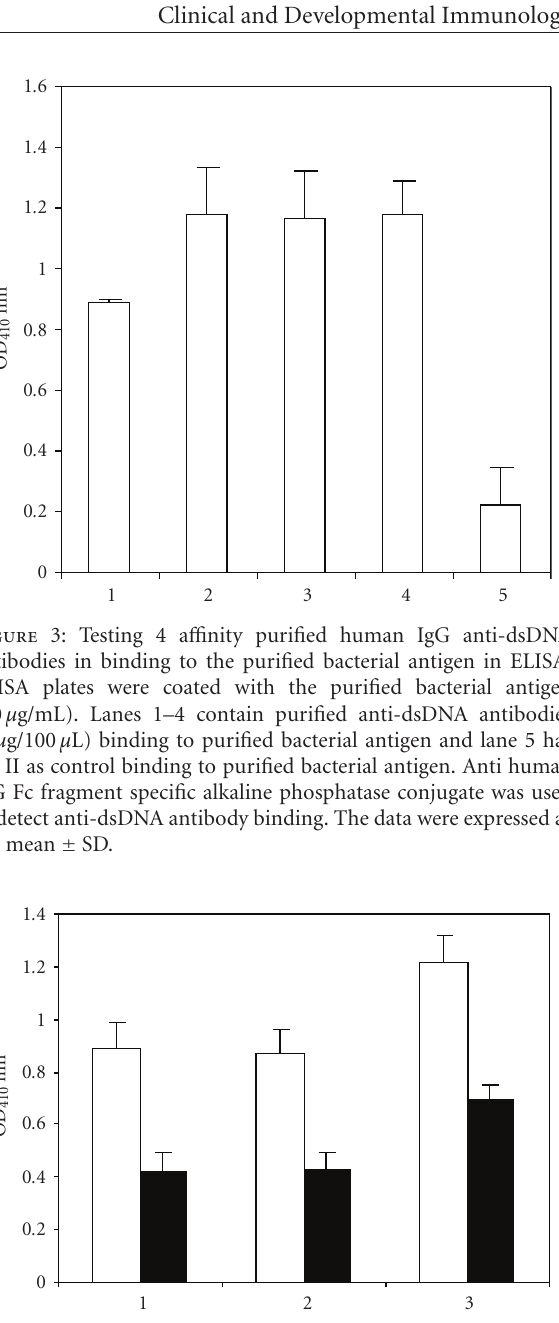
Figure 4: Inhibition of anti-dsDNA antibodies binding to dsDNA antigen by purified bacterial antigen. ELISA plates were coated with dsDNA (50 μ g/mL). Lane 1, 2, and 3 are three di ff erent patients anti-dsDNA antibodies. The light column shows the patient purified anti-dsDNA antibodies (1.25 μ g/100 uL) binding to dsDNA antigen, and dark column shows the patient purified anti- dsDNA antibodies (1.25 μ g/100 uL) mixed with purified bacterial antigen(10 μ g/100 uL). The data were expressed as the mean ±